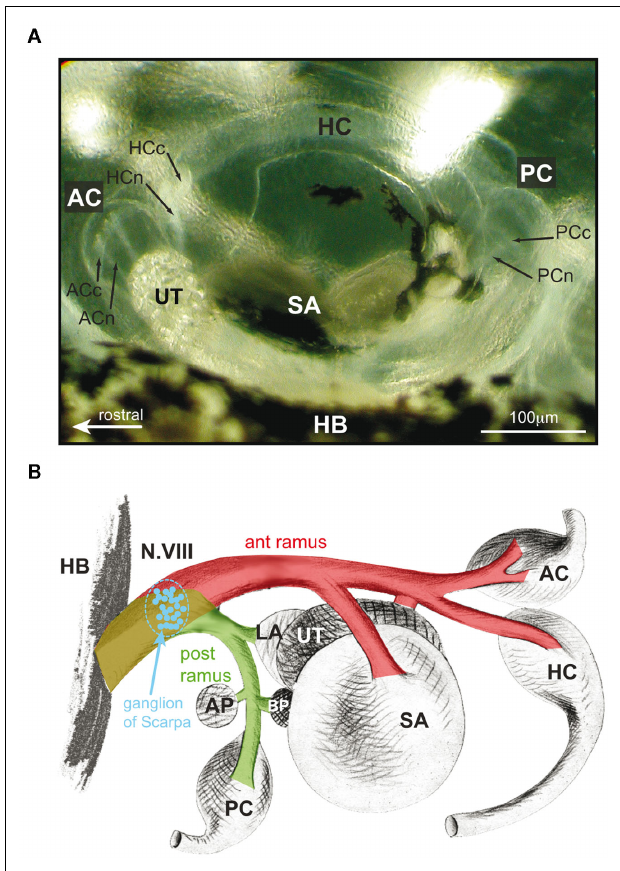
FIGURE 1 | Morphological organization and afferent innervation of labyrinthine endorgans in amphibians. (A) Top view of the otic capsule with semicircular canal and otolith organs of a stage 53 Xenopus laevis tadpole. (B) Color-coded schematic drawing of theVIIIth nerve, ganglion of Scarpa (blue), separation into an anterior (ant ramus, red) and posterior (post ramus, green) branch, and innervations of individual labyrinthine endorgans in a ranid frog. HC, PC, AC, horizontal, posterior, and anterior vertical canal; HCn, HCc, PCn PCc, ACn, ACc, nerve branches (n) innervating the cupula (c) of the semicircular canal organs, respectively; BP, basal papilla; AP, amphibian papilla; SA, saccule; UT, utricle; HB, hindbrain; ant/post ramus, anterior/posteriorVIIIth nerve branch; modified and adapted from Goto et al.